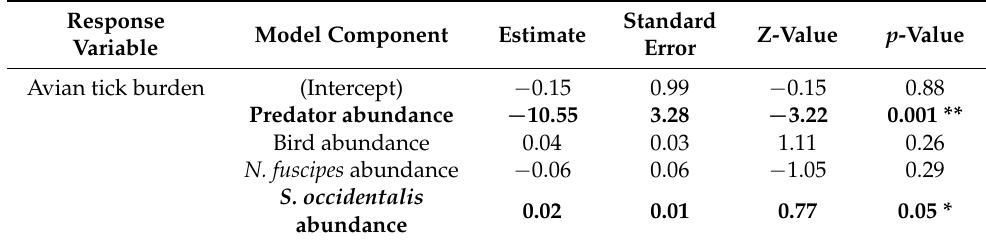
Figure 2. Zero-inflated Poisson distributed generalized linear model result of relative predator abundance and S. occidentalis lizard abundance as predictors of avian tick burden with site as a random effect. Raw data jittered over model prediction. Table 2. Zero-inflated Poisson generalized linear model results of host community characteristics as predictors of avian tick burden with site as a random variable.